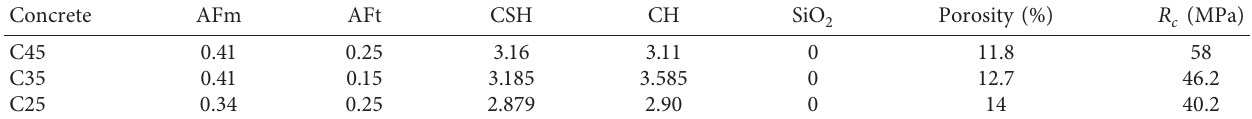
Table 7: Physicochemical properties